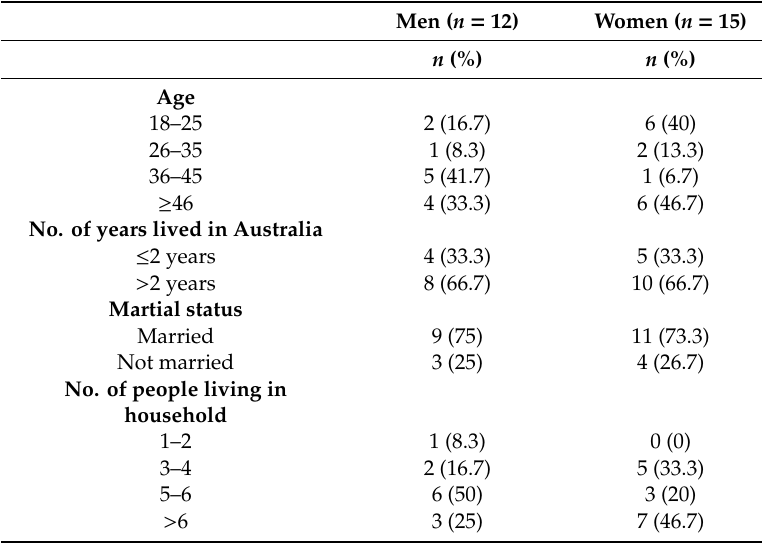
Table 1. Participant